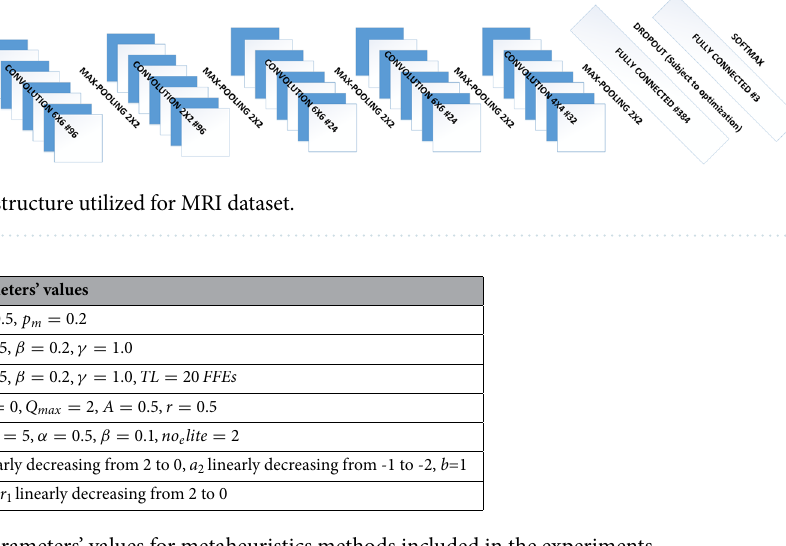
Table 11. Control parameters’ values for metaheuristics methods included in the experiments.